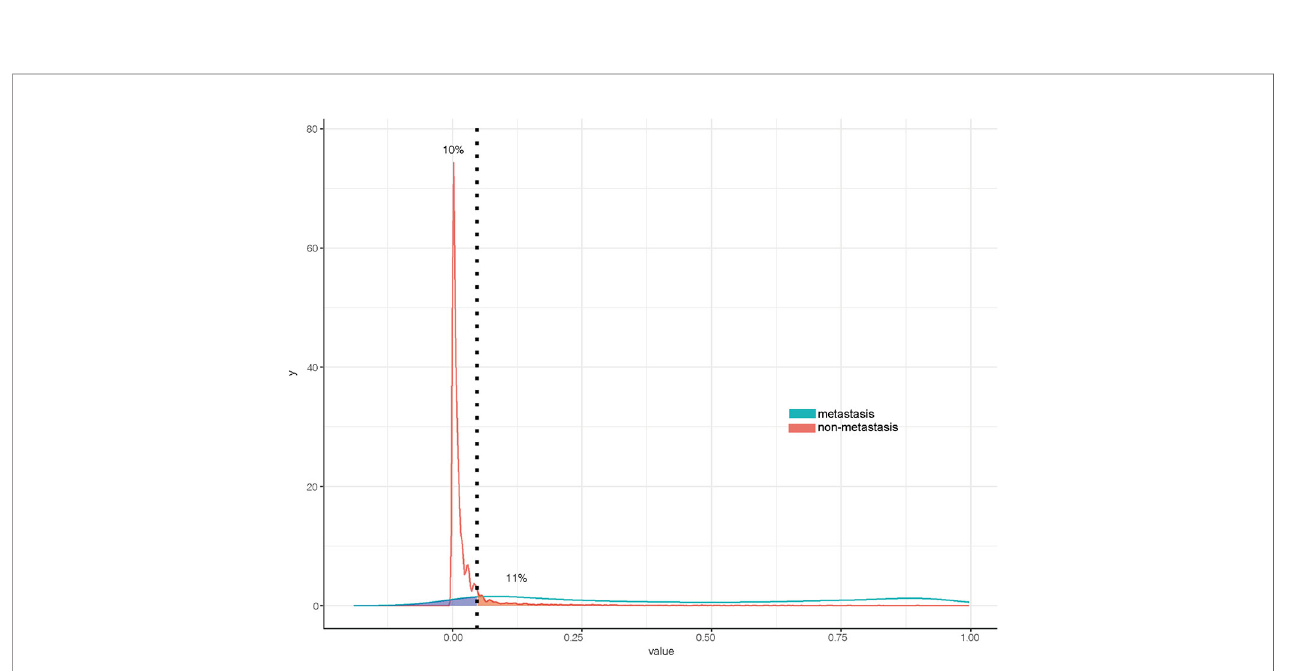
FIGURE 3 | Calibration plots of the nomogram. (A) The calibration plots for the training group. (B) The calibration plots for the validation group. These curves show the correlation between the predicted probability ( x -axis) and the actual incidence of the event ( y -axis).